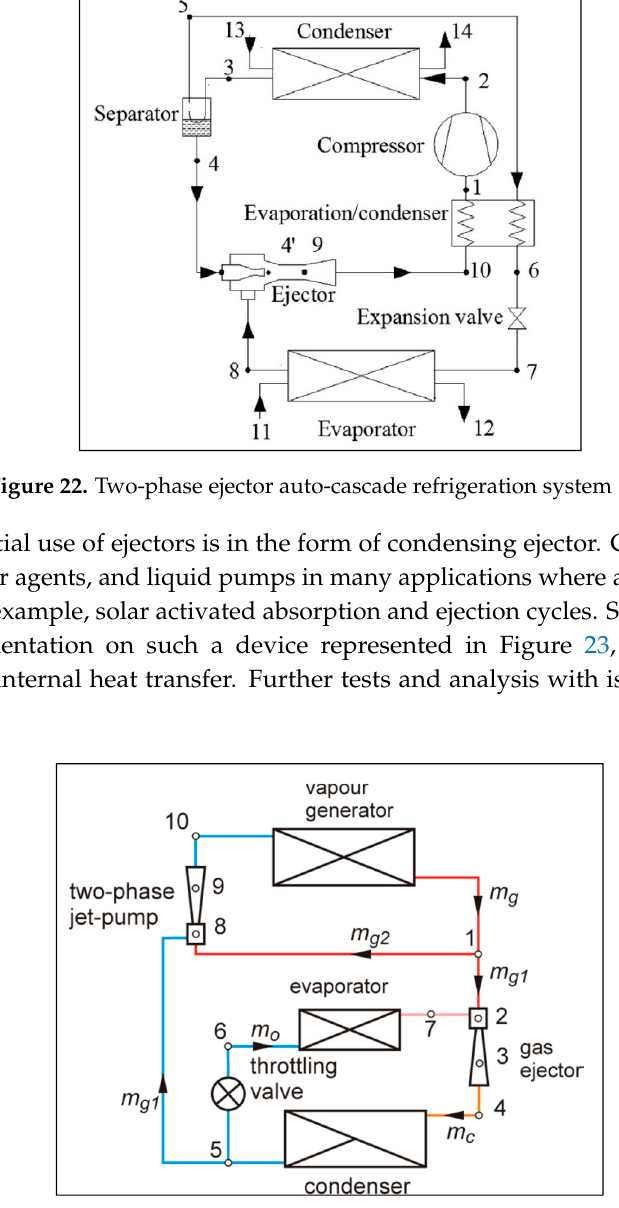
Figure 23. Modified EERC system with two-phase injector [200].